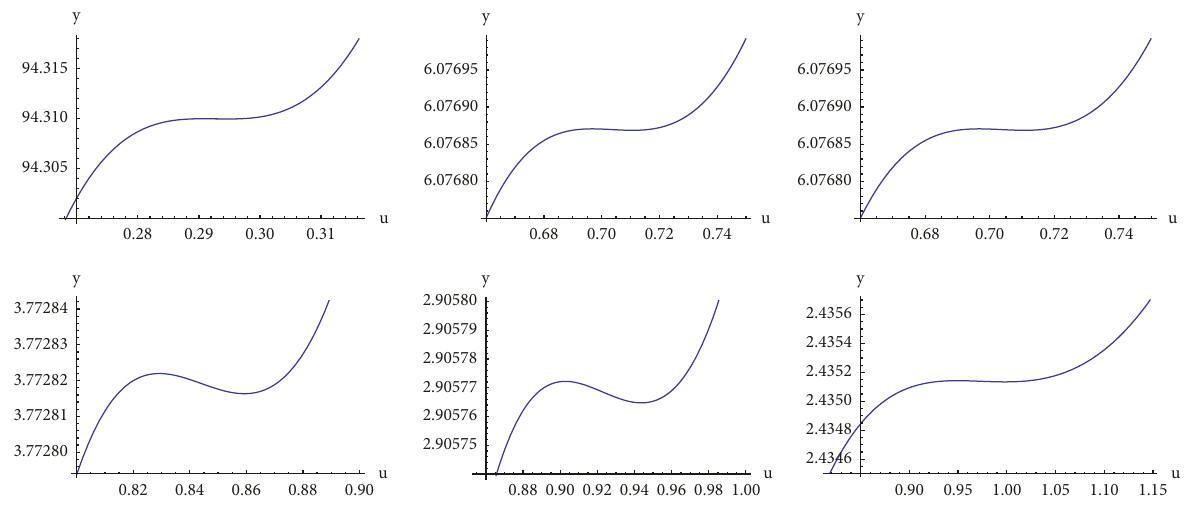
( u ) for S ( σ ) in Table 2. σ ,K 2